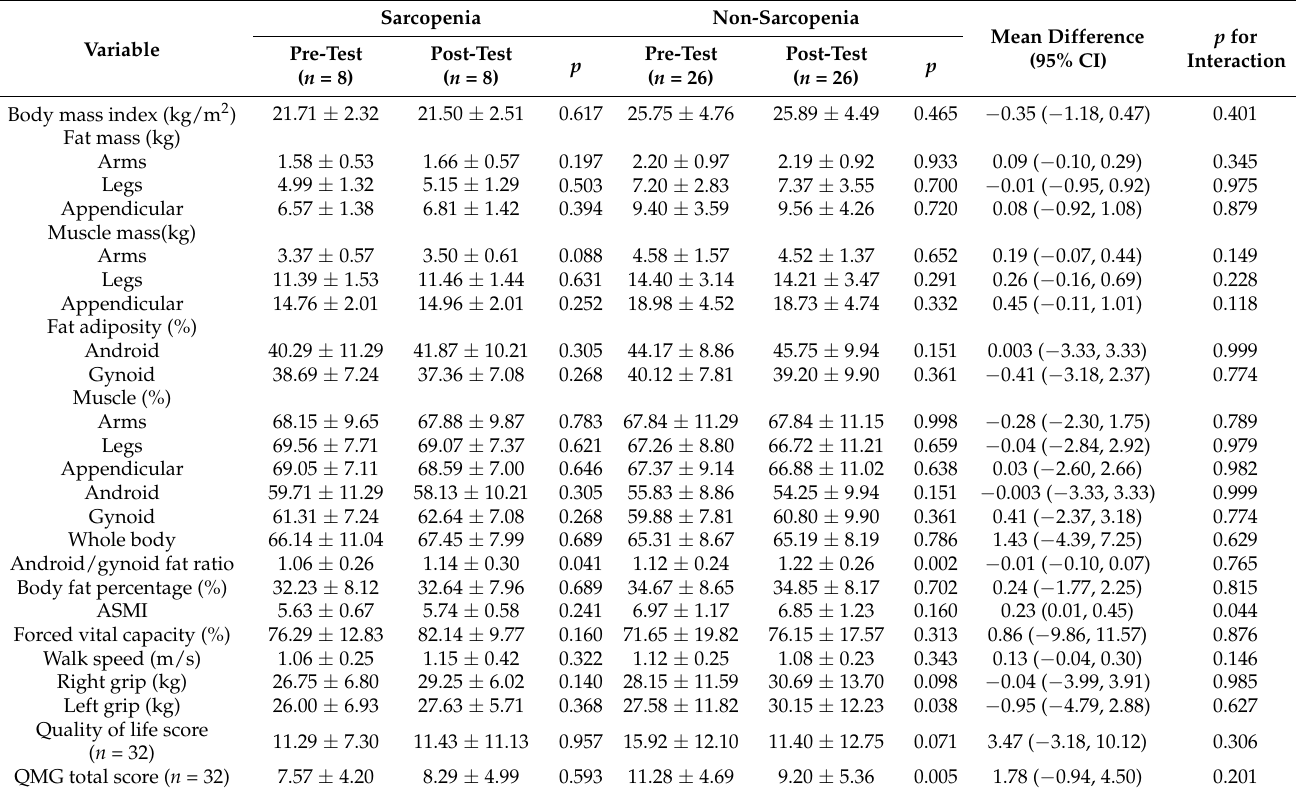
Figure 2. The grouped data of forced vital capacity, walking speed, QMG and QOL scores from the baseline to the end of the 24-week training period stratified by median time spent exercising per week. There is significance difference between groups in force vital capacity ( A ) and walking speed ( B ), the high exercise group also showed significance improvement in QOL score ( C ) and QMG score ( D ) after exercise training. QMG, quantitative myasthenia gravis; QOL, quality of life. Table 4. Body composition of patients with MG before and after resistance training according to presence or absence of